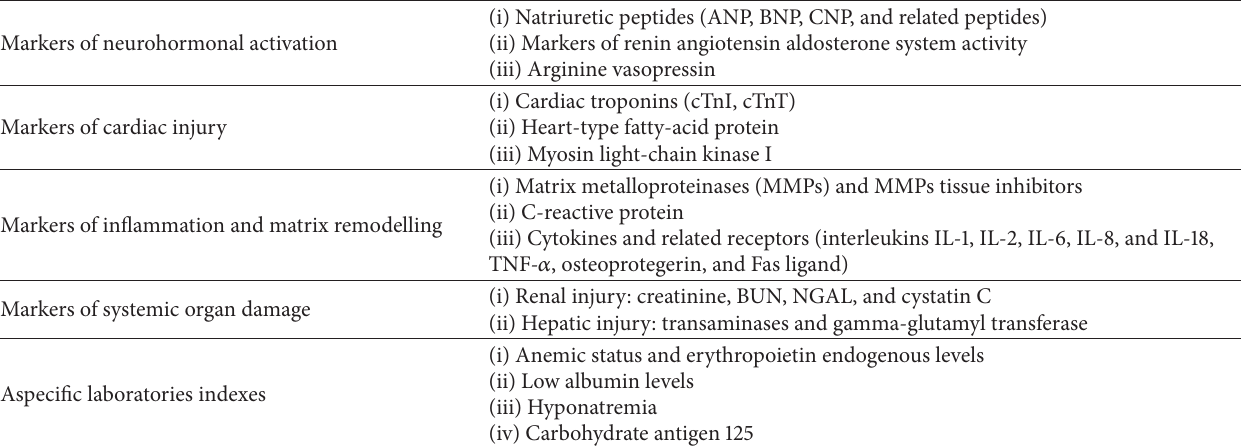
Table 1: Classification of biomarkers for early cardiac damage identification.